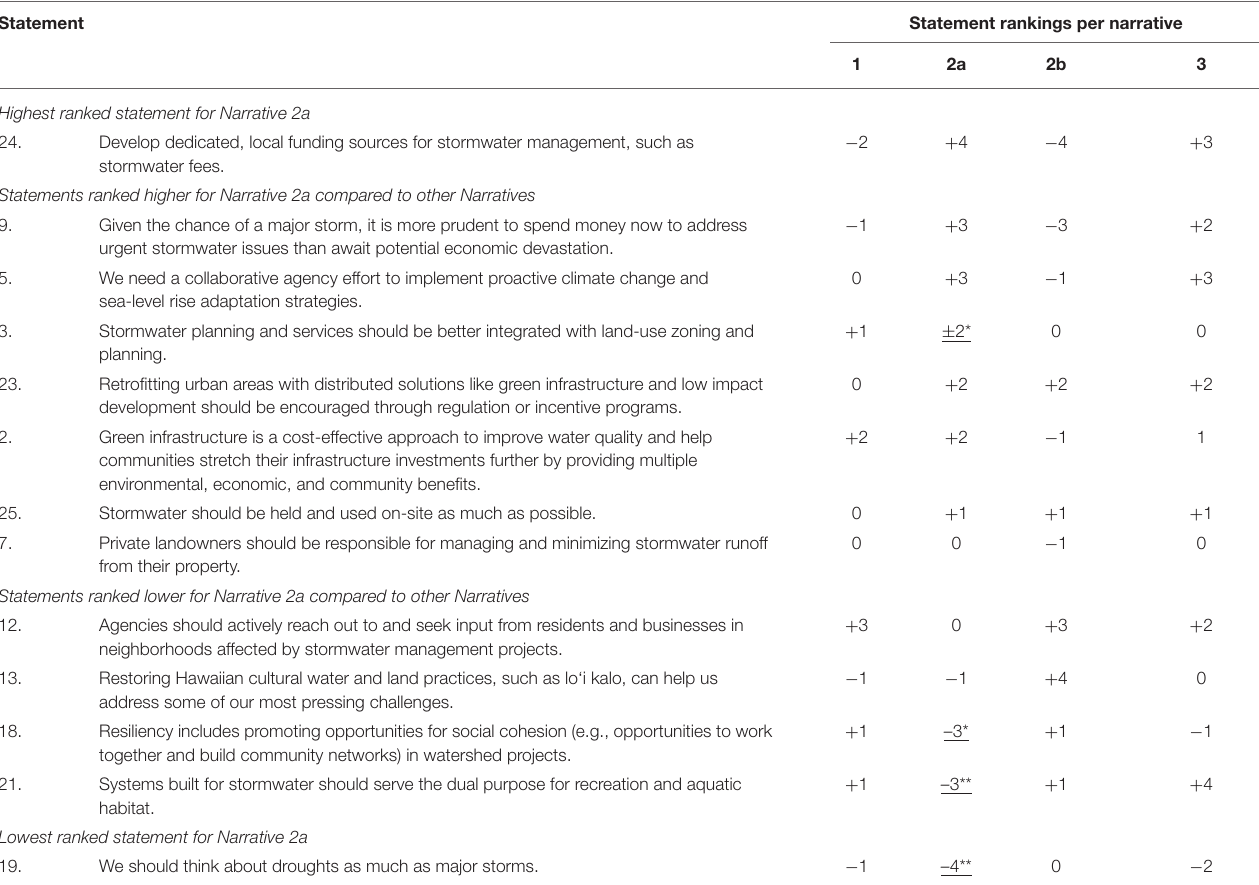
TABLE 5 | Summary of notable statements for narrative 2a (PC